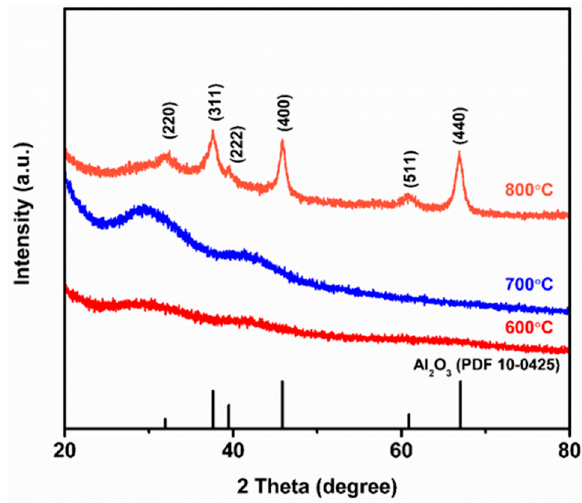
Figure 4. XRD patterns of electrospun Al 2 O 3 precursor fibers annealed for 2 h in the air at various temperatures (600 °C–800 °C).